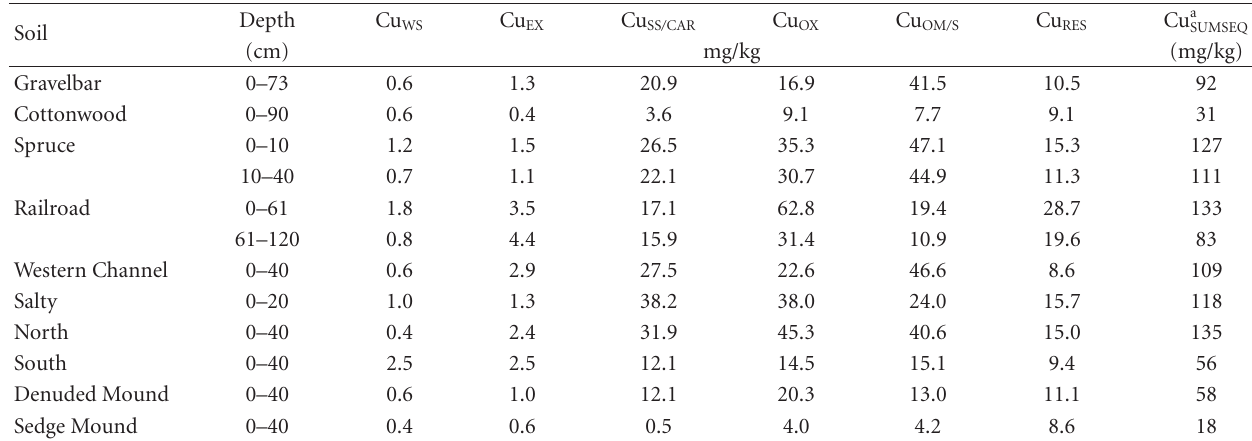
Table 13: Sequential fractionation of Cu in study